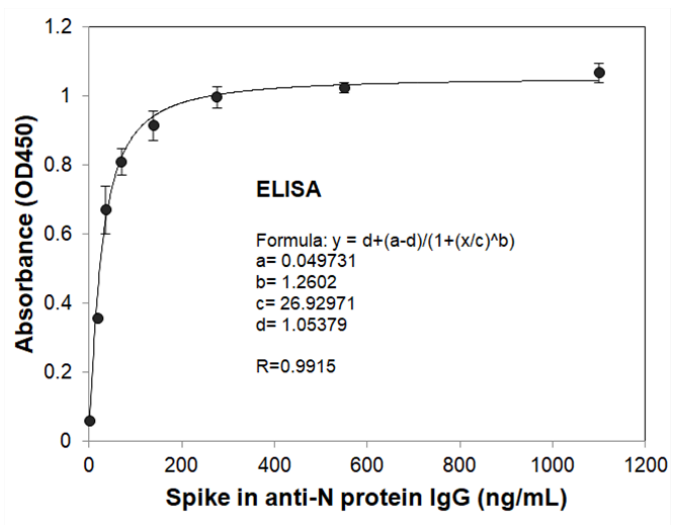
Figure 8. 4PL curve of ELISA with OD450 absorbance signals of different concentrations of spike-in IgG samples. The spike-in IgG samples at different concentrations (34.375–1100 ng/mL) and blanks (serum only) for ELISA measurements as described in the Materials and Methods.